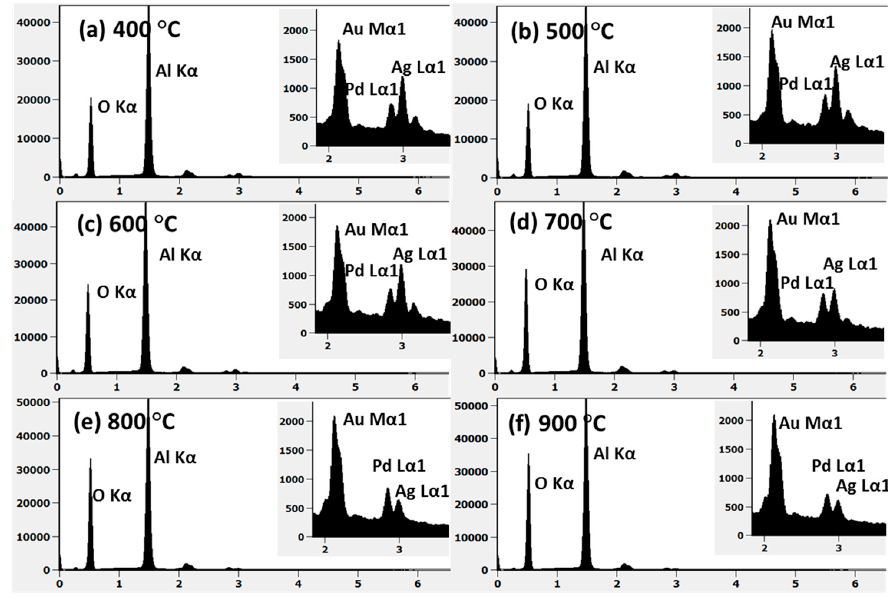
Figure A4. ( a – f ) EDS spectra of the AuAgPd alloy NPs on sapphire shown in Figure A3. Insets show the evolution of Au M α 1, Pd L α 1, and Ag L α 1 peaks with annealing temperature.